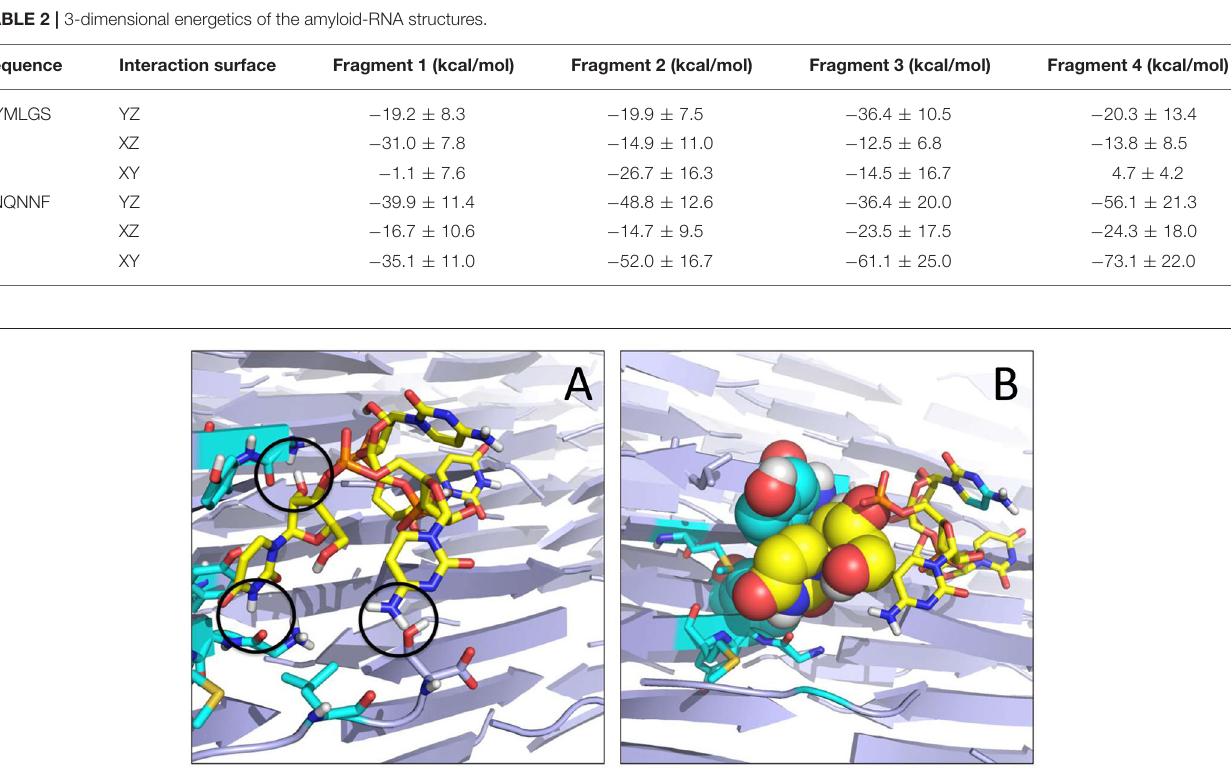
FIGURE 4 | Organization of the RNA tetramer on the surface of the GYMLGS aggregate. (A) RNA forms different h-bonds on the surface (black circles). (B) Detail of the packing of U5 (yellow) with Y residues from the peptide assembly.